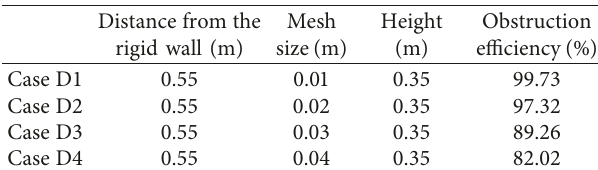
Table 6: The obstruction efficiency of RNB with different mesh sizes toward graded grains.